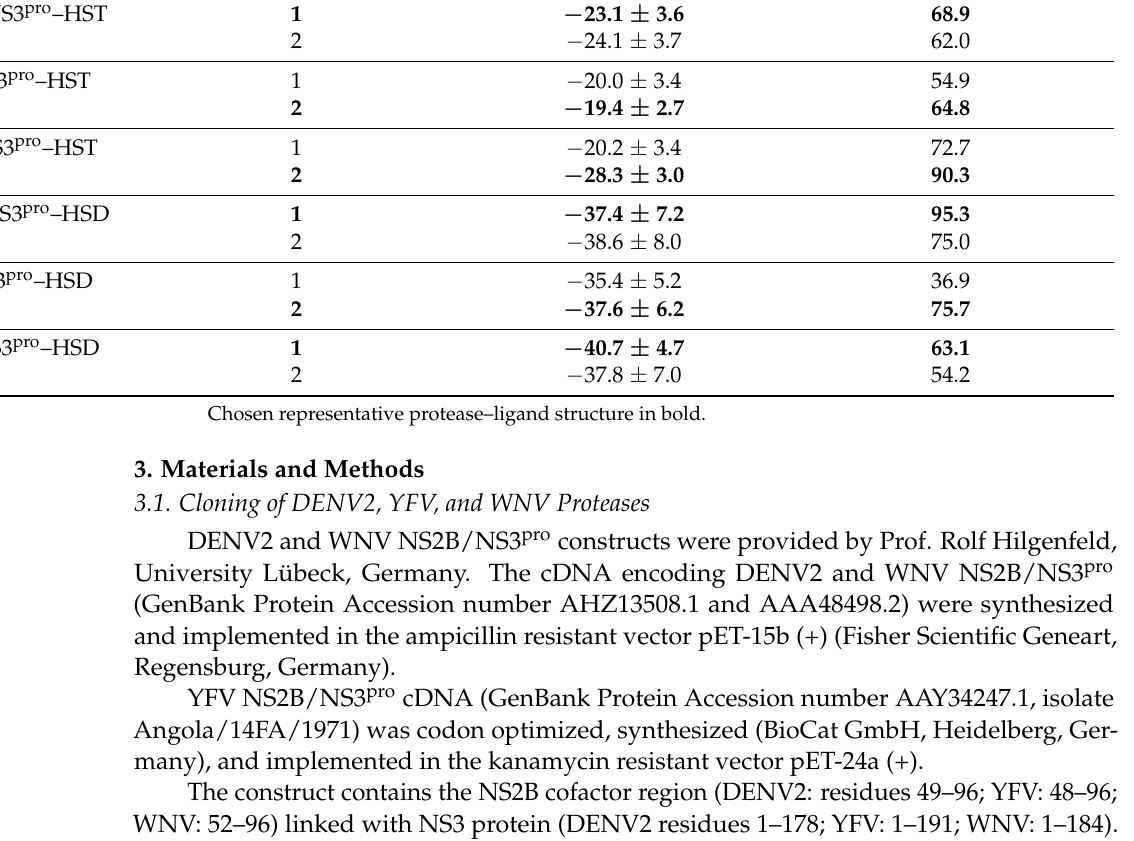
Table 3. Summary of the MD simulation replicas 1 and 2 of DENV2, YFVm and WNV NS2B/NS3 pro in complex (with HST and HSD molecules). Protein +